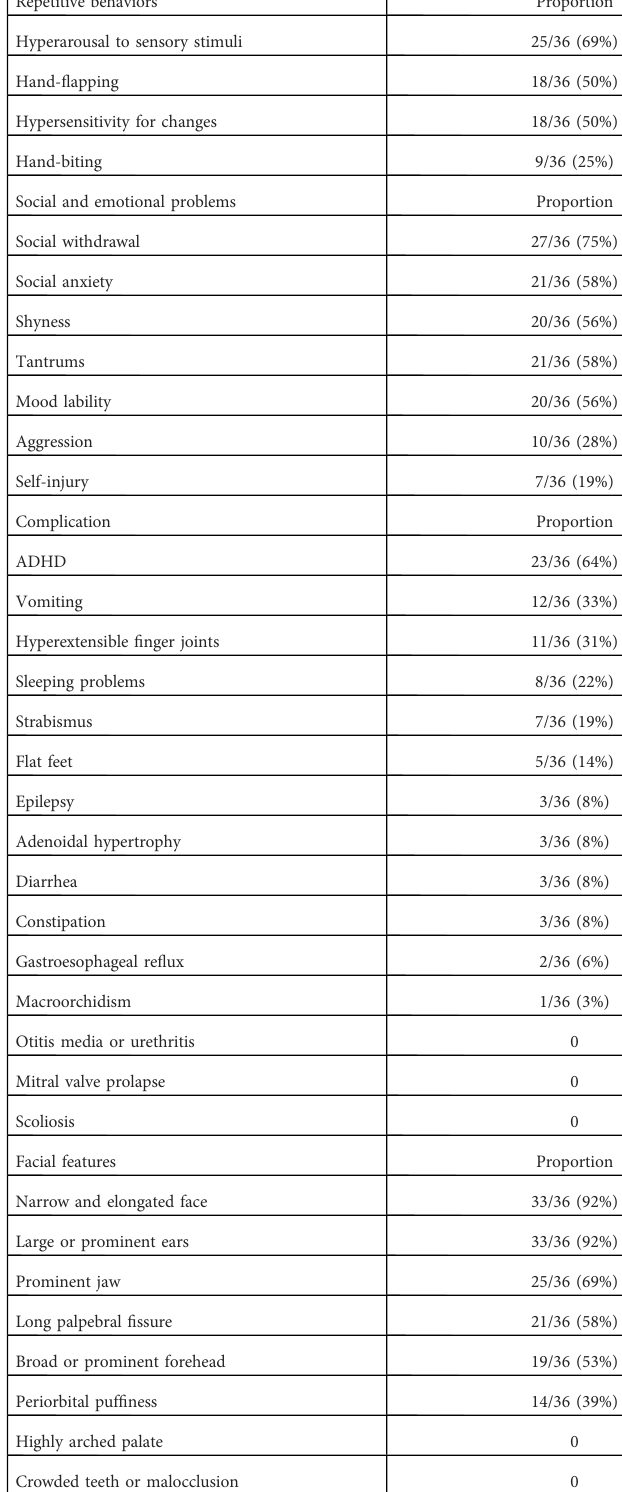
TABLE 2 Statistics of basic information, general growth, and development of FXS children.